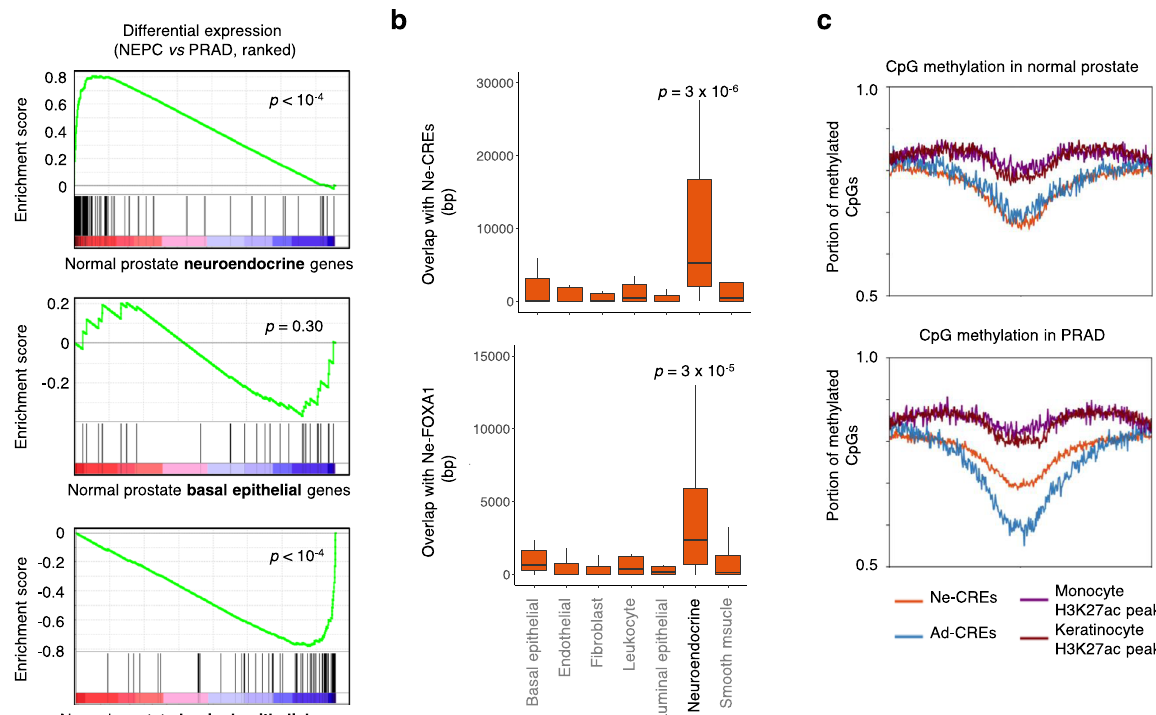
Fig. 5 Gene expression of benign prostate cells compared to NEPC transcriptomes and epigenomes. a Gene set enrichment analysis of genes speci fi cally expressed in neuroendocrine, basal, and luminal cells from normal prostate 73 . Genes are ranked by differential expression in NEPC and PRAD LuCaP PDXs. b Overlap of NEPC-enriched H3K27ac peaks (Ne-CREs; n = 14,985; top) and FOXA1-binding sites (Ne-FOXA1; n = 20,935; bottom) with a 200 kb windows centered on the transcriptional start sites of the 20 most signi fi cantly differentially expressed genes in each indicated prostate cell type 73 . Box boundaries correspond to 1st and 3rd quartiles; whiskers extend to a maximum of 1.5x the inter-quartile range. p -values correspond to two-sided Wilcoxon test of Ne-CRE/Ne-FOXA1 peak overlap near neuroendocrine cell genes versus all other indicated gene categories. c Fraction of CpG methylation detected by whole-genome bisul fi te sequencing in normal prostates tissue and PRAD at Ne-CREs and Ad-CREs. Methylation levels at H3K27ac peaks identi fi ed in epithelial keratinocytes or in peripheral blood monocytes are included for comparison. x -axis corresponds to peak center ±3